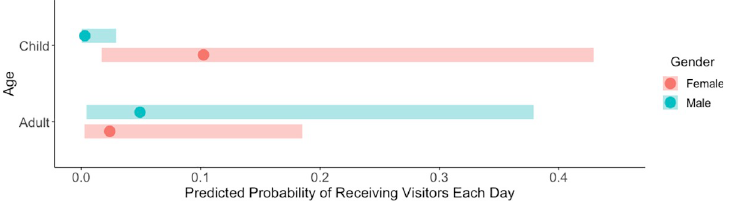
Fig 1. Predicted probability of receiving a visitor on each day of illness, based on a GLMM fitted to data of DENV infected individuals in Iquitos, Peru. Data are presented in terms of age group and sex. Error bars represent 95% Confidence